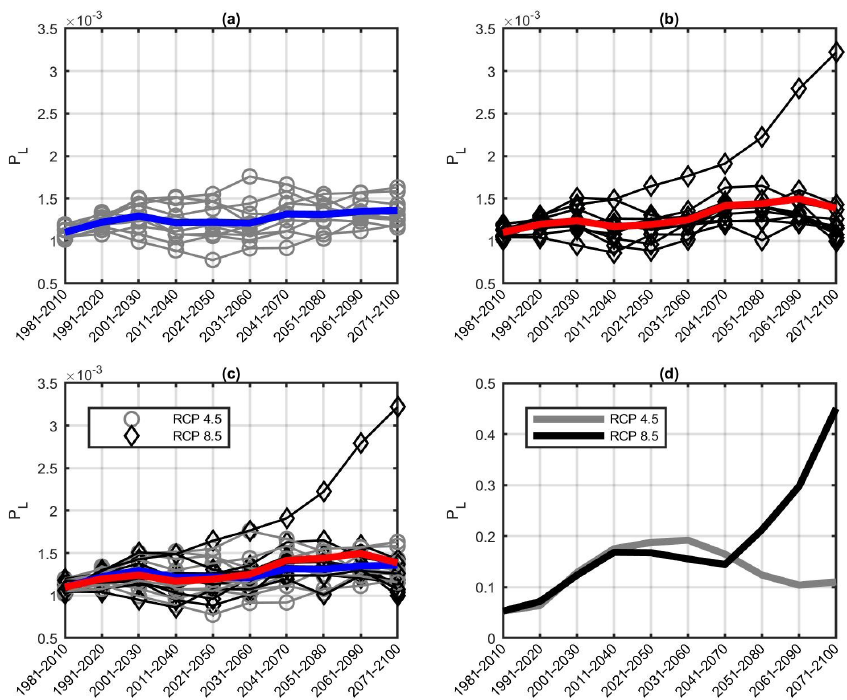
Figure 8. Outputs of the second-moment statistical analysis of landslide occurrence probability P L